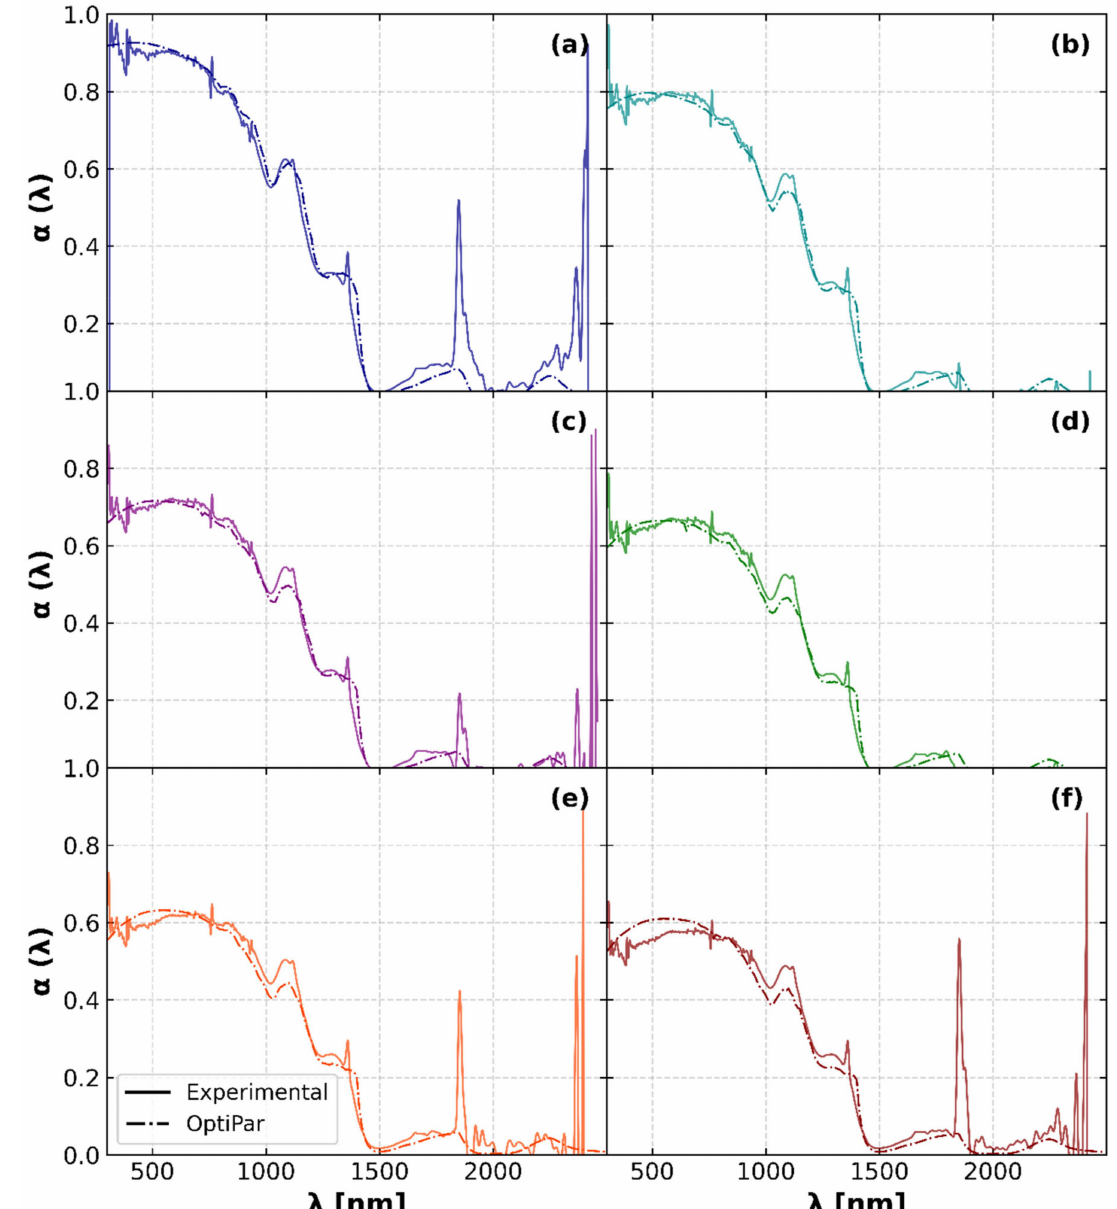
Figure 7. Experimental (continuous lines) and OptiPar modelled (dashed lines) albedo ( α ) results for snow surface contaminated with ( a ) 0.65, ( b ) 2.32, ( c ) 3.99, ( d ) 5.66, ( e ) 7.33, and ( f ) 9.00 mg/kg of